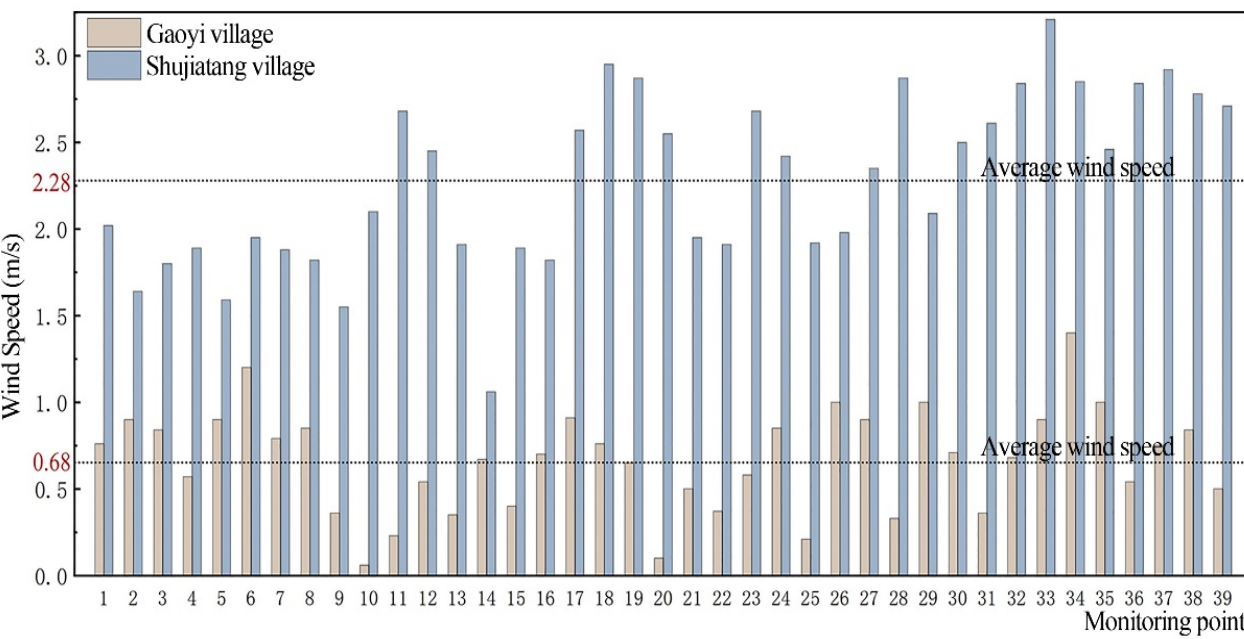
Figure 14. The monitoring results of the open-space windspeed for High chair and Shujiatang Vil- lages.